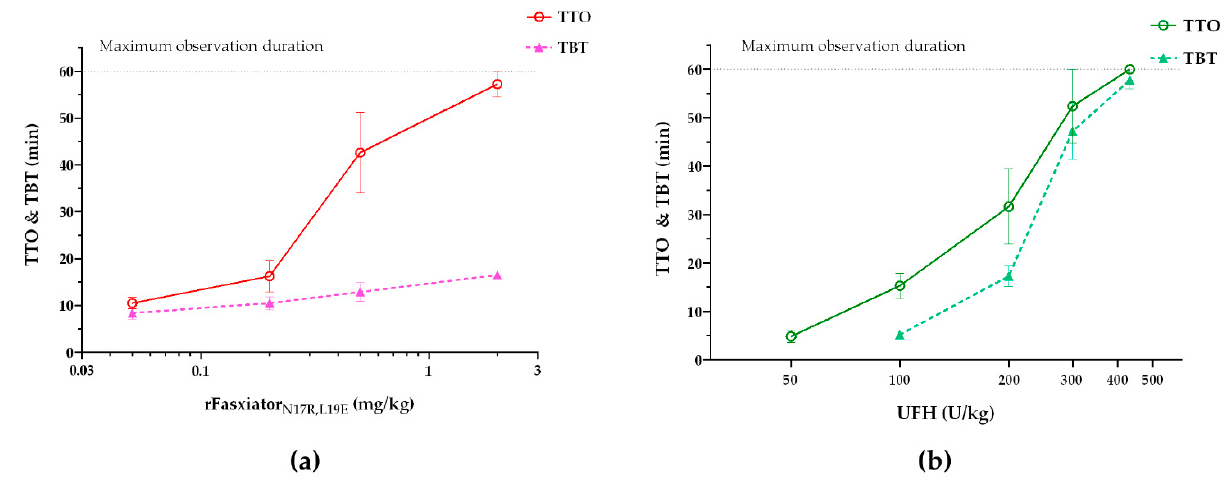
Figure 4. FeCl 3 ‐ induced carotid artery thrombosis (CAT) and tail bleeding model in rats. ( a ) Time ‐ to ‐ occlusion (TTO) of the FeCl 3 ‐ induced CAT model in rats treated with rFasxiator N17R, L19E at 0.05 ( n = 6), 0.2 ( n = 6), 0.5 ( n = 6), and 2 ( n = 4) mg/kg were plotted as red open circles. Tail bleeding time (TBT) of rats treated with rFasxiator N17R, L19E at 0.05 ( n = 6), 0.2 ( n = 6), 0.5 ( n = 6), and 2 ( n = 6) mg/kg were plotted as pink solid triangles. The gray dash line represents the maximum observation dura ‐ tion of 60 min in both models. ( b ) TTO of the FeCl 3 ‐ induced CAT model in rats treated with unfrac ‐ tionated heparin (UFH) at 50 ( n = 5), 100 ( n = 6), 200 ( n = 7), 300 ( n = 5), and 432 ( n = 5) U/kg were plotted as dark green open circles. TBT of rats treated with UFH at 100 ( n = 6), 200 ( n = 7), 300 ( n = 5), and 432 ( n = 5) U/kg were plotted as light green solid triangles. The gray dotted line represents the maximum observation duration of 60 min in both models.